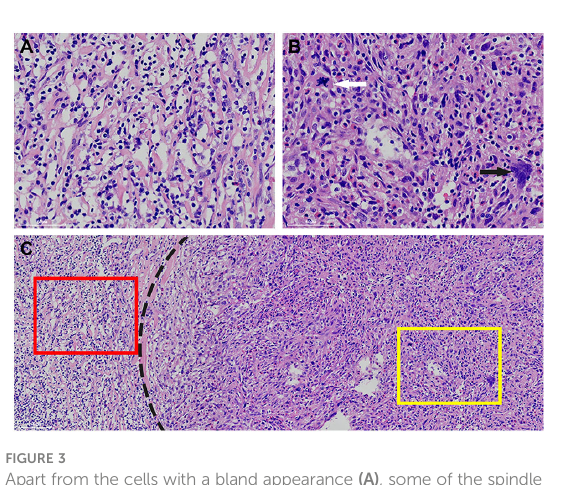
FIGURE 3 Apart from the cells with a bland appearance (A) , some of the spindle cells demonstrate remarkably pleomorphism. Abnormal mitoses (white arrow) and multinucleated tumor cells (black arrow) could be observed (B) . There exists a morphological transition between the bland (left side of the dot line) and atypical cellular regions (right side of the dot line). The high power fi elds of the red square and the yellow square are corresponding to (A, B) , respectively (C)